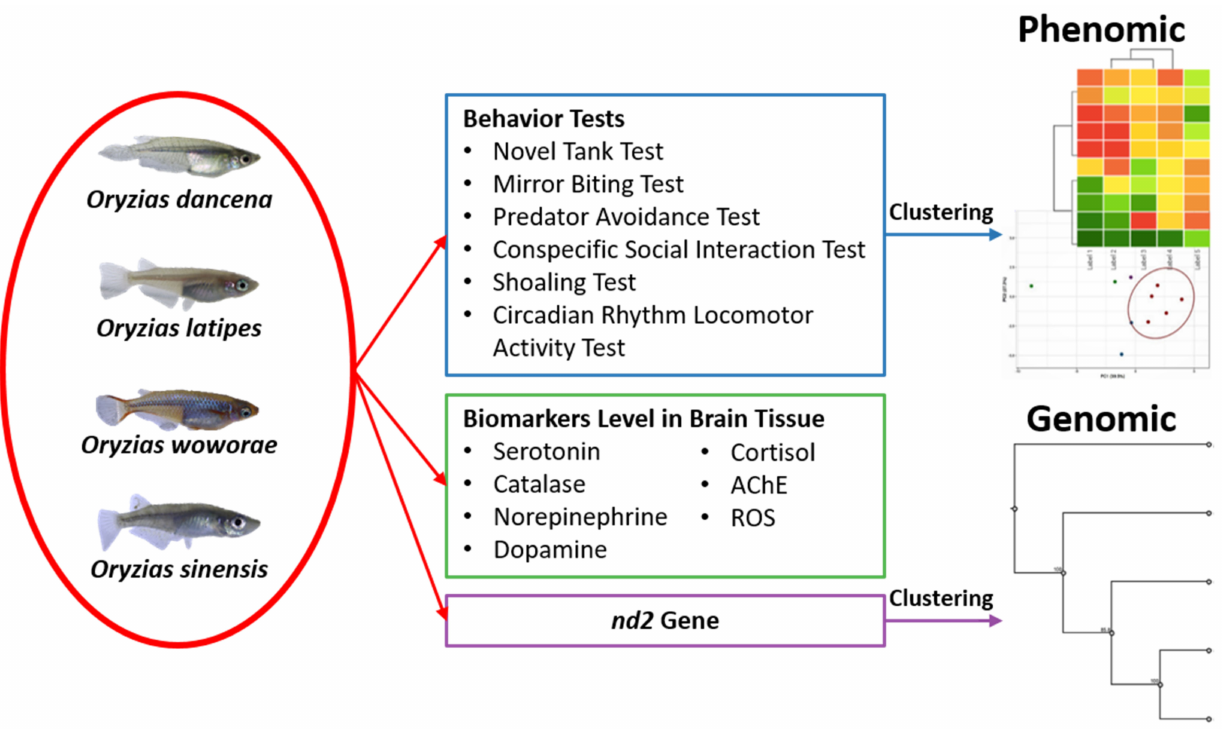
Figure A1. Overview of the experimental design in the present study. Table A1. The individual P-value of each fish behavioral endpoint comparison in the novel tank test. The P-values were obtained from a two-way ANOVA test with Geisser–Greenhouse correction continued with uncorrected Fisher’s LSD test. p -values less than 0.05 are written in